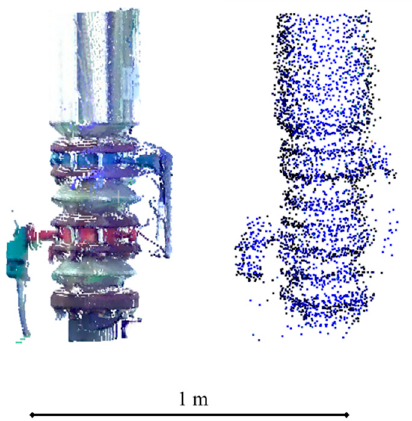
Figure 10. Example of points clouds of the cutting valve at the entrance of the water in the boilers obtained with Faro (Left) and with Zeb-Revo (Right).